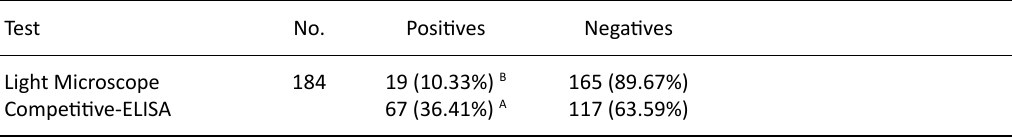
Table 1. Prevalence of A. marginale in an overall 184 buffaloes